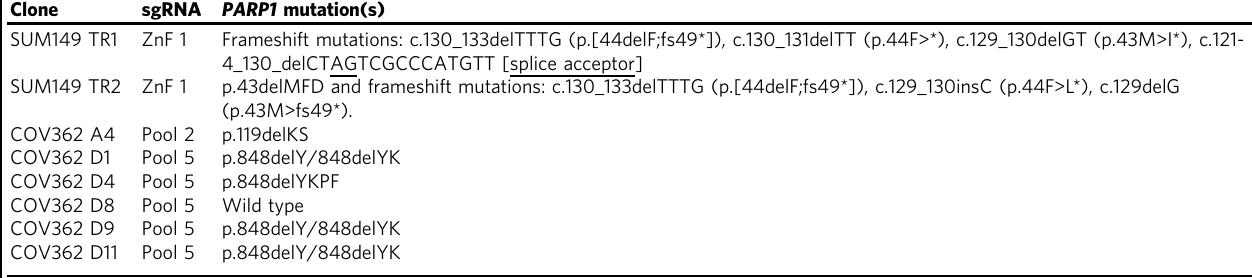
Table 3 PARP1 mutations identi fi ed in talazoparib-resistant SUM149 and COV362 clones, determined by Sanger